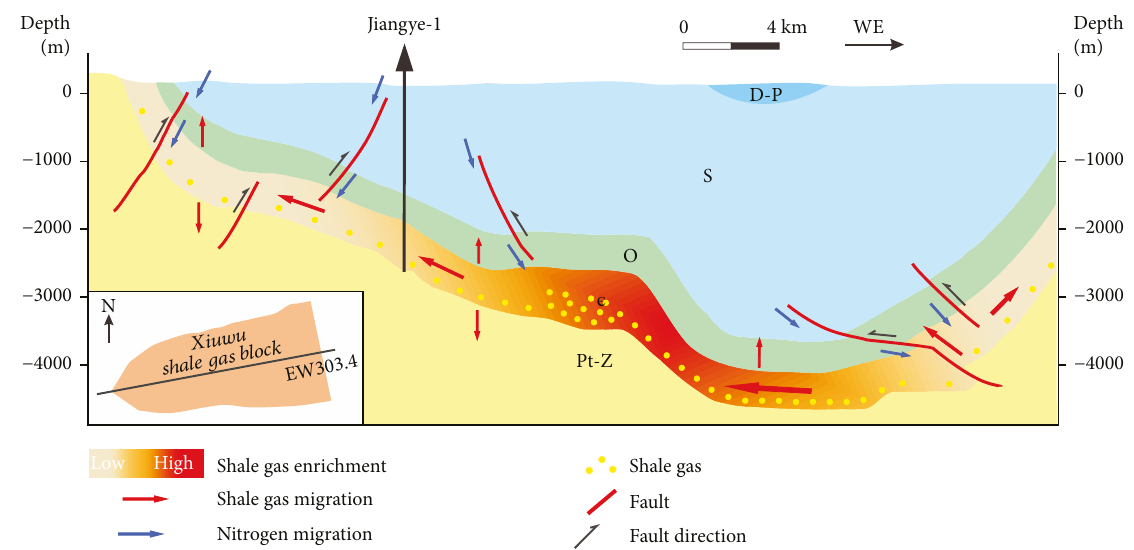
Figure 9: Hydrocarbon gas di ff uses and nitrogen from atmosphere entrances through bedding planes, the detachment layer, and deep faults in section of EW303.4 through Xiuwu Basin. See Figure 1 for the well locations.